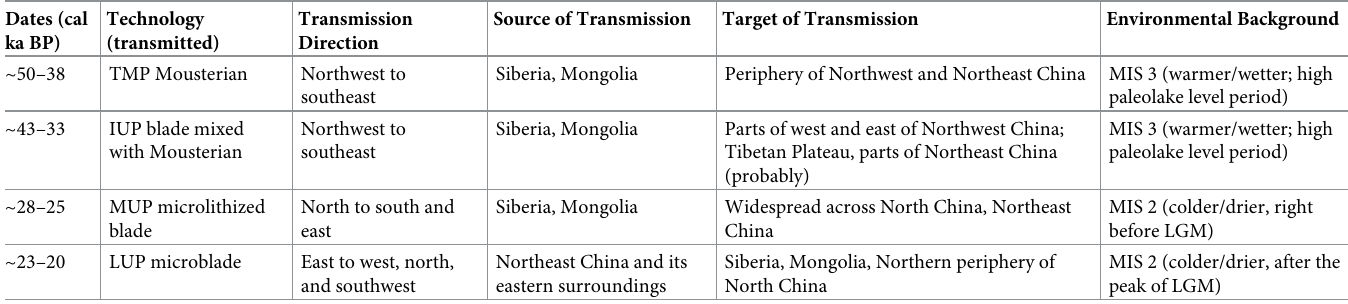
Table 3. Summary of the patterns of each wave of technological transmission between the east Eurasian Steppe and northern China in the Late